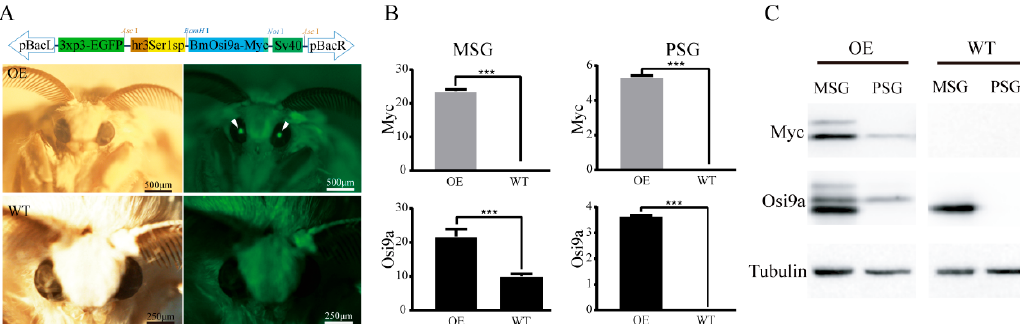
Figure 1. Transgenic overexpression of BmOsiris9a in the silk gland. ( A ). The transgenic expression vector pBac [hSer1sp-BmOsi9a-Sv40, 3xp3-EGFPaf] was constructed to overexpress BmOsi9a of B. mori . Fluorescent images of a G1 moth of the transgenic overexpression (OE) of BmOsi9a and the wild type (WT). Arrowheads denote the positions of GFP fluorescence. B . Relative mRNA levels of BmOsi9a and Myc were investigated by qRT-PCR in the middle silk gland (MSG) and the posterior silk gland (PSG) of the OE and the WT. sw22934 was used as a control (*** p < 0.001). C . Immunoblot analysis of BmOsi9a and Myc-tag in the MSG and the PSG of the OE and the WT. Proteins dissolved from the MSG and the PSG were separated by SDS-PAGE and immunoblotted with anti-BmOsi9a and anti-Myc antibodies. Tubulin was used as a control.